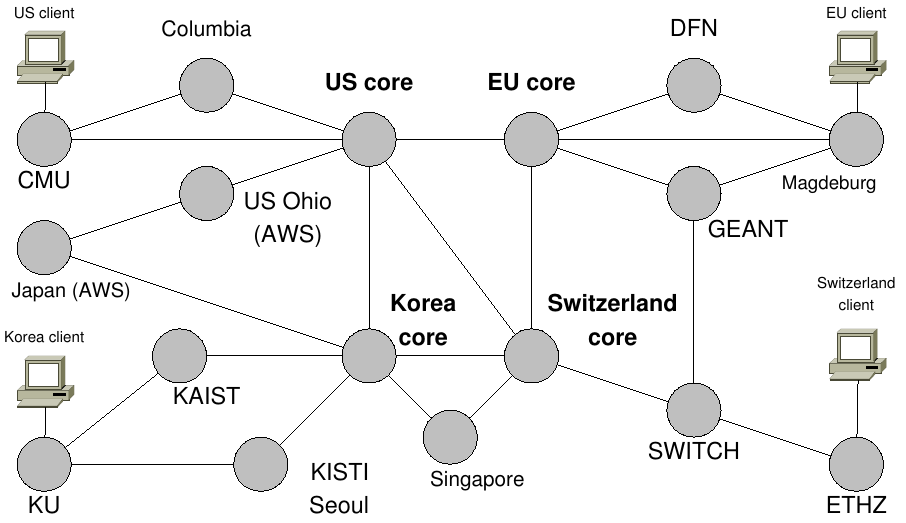
Figure 4. Global topology using SCIONLab for a real-world network evaluation. The core ASes are placed at Carnegie Mellon University (CMU) in the United States (US), Magdeburg in Germany, SWISSCOM (SCMN) in Switzerland, NUS in Singapore, and KISTI Daejeon in Korea. The links between the core ASes are operated as a transit-link for communication. All links are adopted as multi-path to show the effectiveness of MMP. The ETHZ node includes two